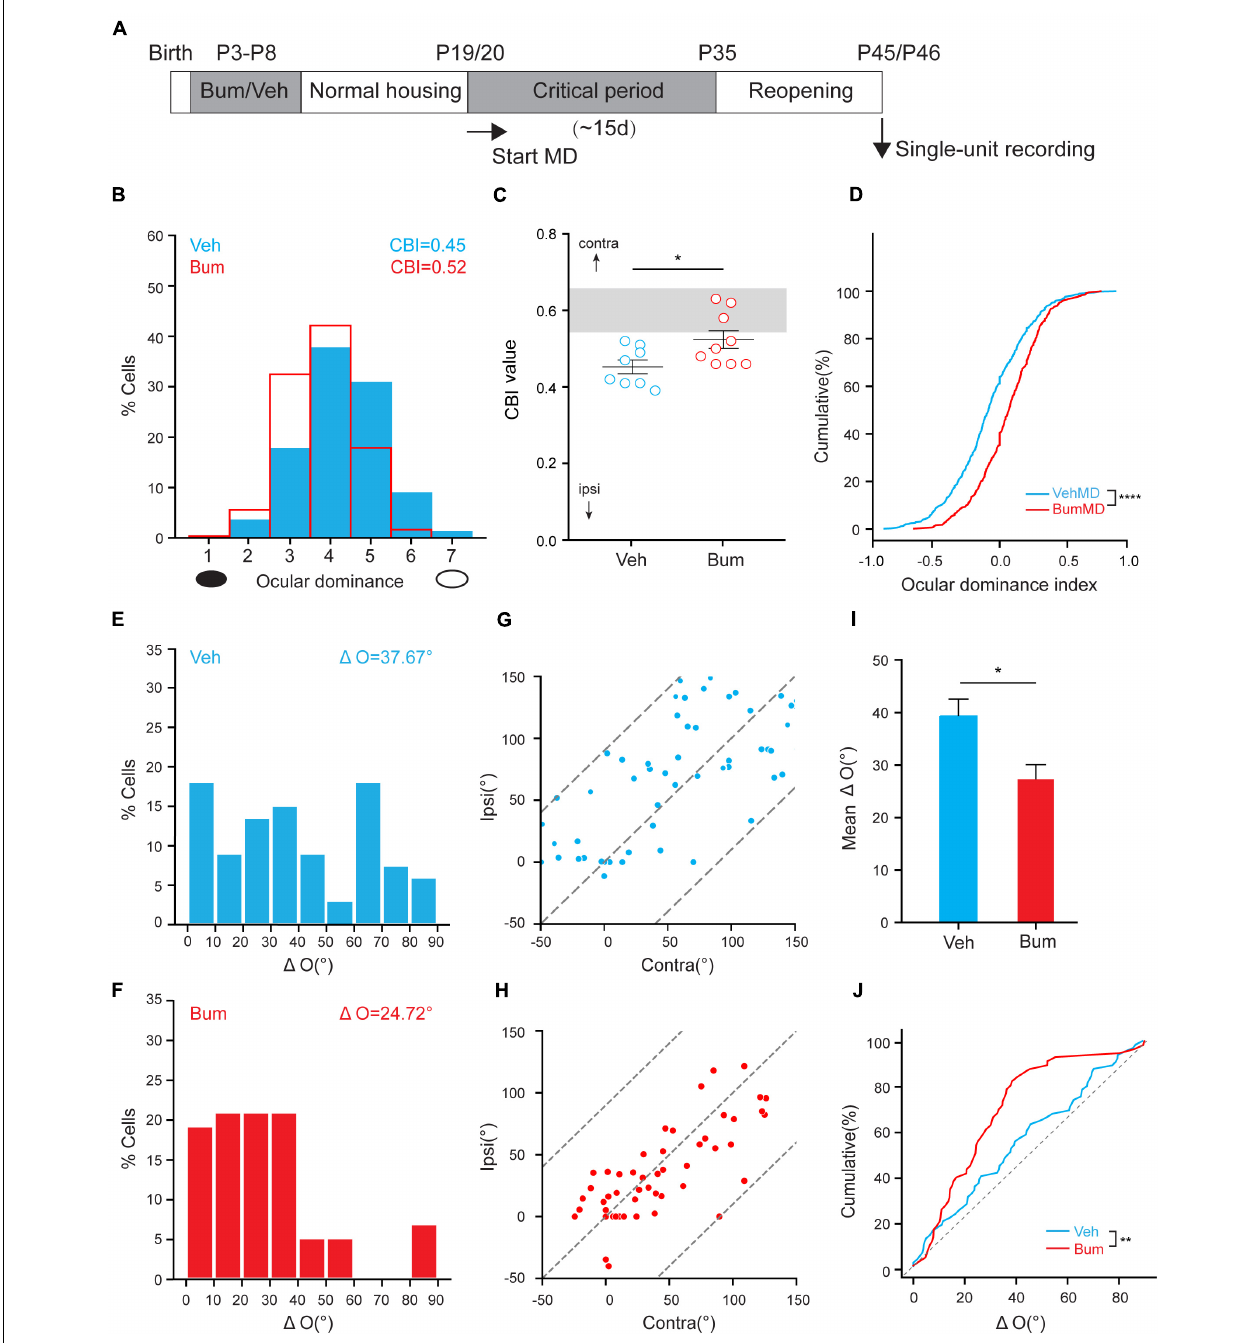
FIGURE 9 | The extended critical period with normal vision rescued binocular matching following long-term monocular deprivation (LTMD) in Bum mice. (A) Schematic of experimental design. (B) OD distribution for Veh and Bum mice with LTMD. The OD distribution was shifted toward the non-deprived eye for Veh mice, while Bum mice showed contralateral bias ( p = 0.031, Mann-Whitney rank-sum test). (C) OD plasticity was quantified by the values of CBI (Veh: 0.45 ± 0.016, eight mice; Bum: 0.52 ± 0.021, nine mice). Open circles represent individual CBIs for each animal. (D) OD cumulative distribution for Veh and Bum group. OD distribution for Bum group (610 cells, nine mice) was statistically different from Veh mice (686 cells, eight mice, p < 0.0001, K-S test). (E,F) Distribution of the difference in interocular orientation preference in Veh and Bum mice. (E) Veh (cid:49) O = 37.67 ± 3.24 ◦ ; (F) Bum (cid:49) O = 24.72 ± 2.82 ◦ . (G,H) Correlation of monocular orientation preference in Veh and Bum mice. (G) Veh: r = 0.66, p < 0.0001, 69 cells, eight mice; (H) Bum: r = 0.72, p < 0.0001, 60 cells, nine mice. The dotted lines bound the region in which the data points can lie. (I) Mean (cid:49) O was significantly higher in Veh than Bum animals ( p = 0.0108, Mann-Whitney rank-sum test). (J) Cumulative distribution of (cid:49) O for Bum and Veh mice ( p = 0.0044, K-S test). Data were expressed as mean ± SEM. * p < 0.05, ** p < 0.01, **** p < 0.0001.